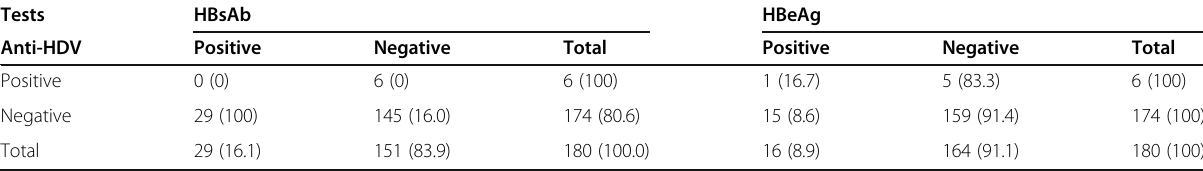
Table 2 Hepatitis B antigenemia among study population among hepatitis D-positive patients Tests HBsAb HBeAg